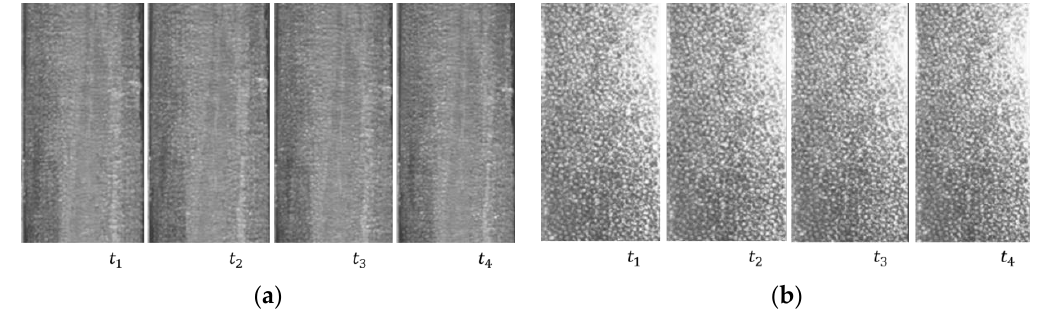
Figure 7. Flow patterns observed from the plain rectangular channel ( a ) and the copper porous media filled channel ( b ) at mean vapor quality are ( a ) = 1.02, ( b ) = 1.07.